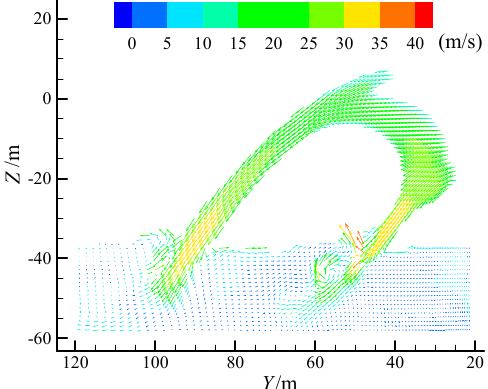
Figure 12. Lateral velocity vector profile of streamwise-lateral ski-jump flow ( X = 100 m).